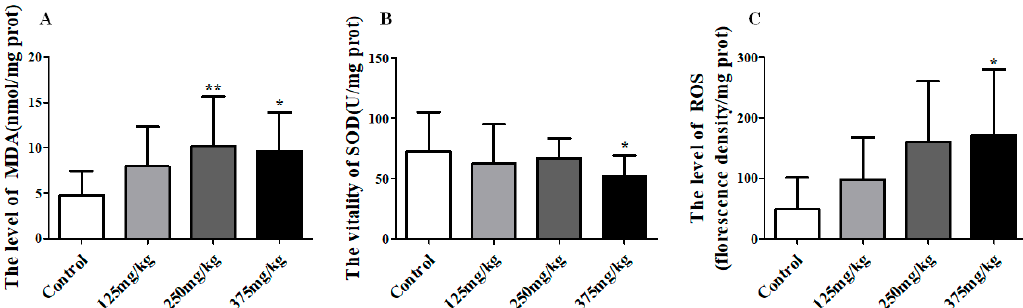
Figure 4. Effect of DEHP exposure on the level of oxidative stress in liver homogenate of mice ( n = 10). ( A ) the level of MDA; ( B ) the activity of SOD; ( C ) the level of ROS. Data represented as means ± SD, * p < 0.05, ** p < 0.01 compared with the control group.